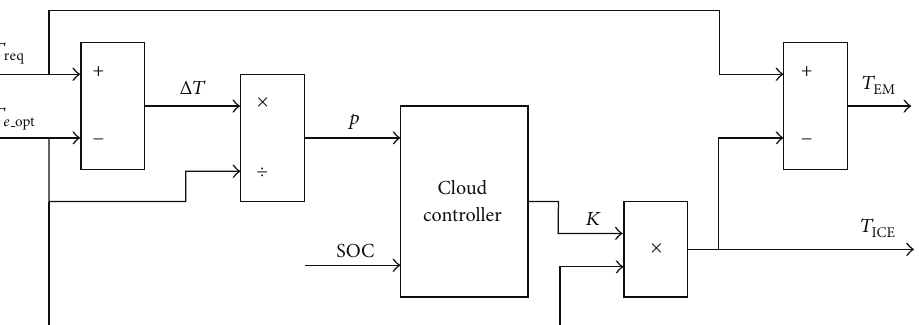
Figure 5: The multirule constructor.